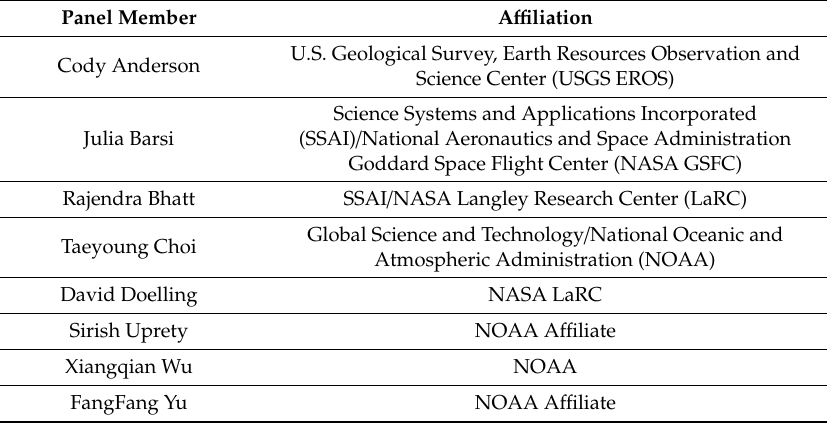
Table 1. List of workshop panel